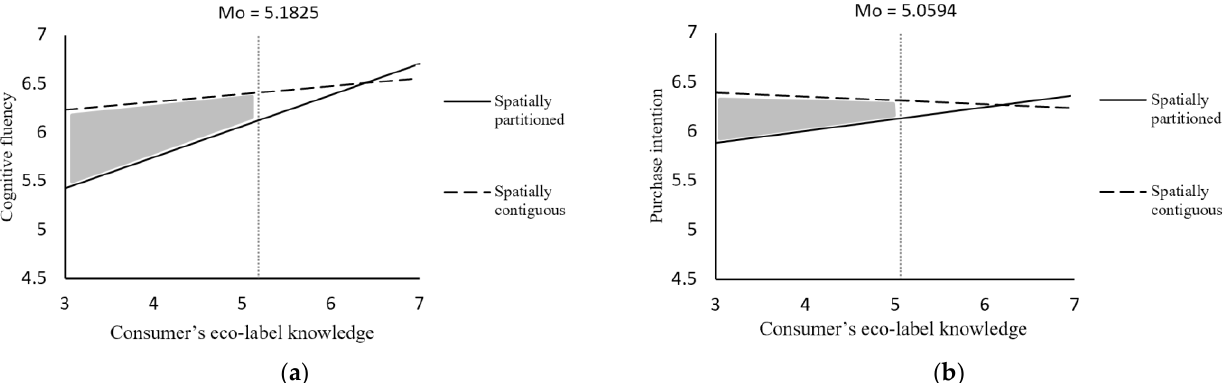
Figure 3. The interactive effect of JPEI spatial distance and consumers’ eco-label knowledge (Study 2). Note: ( a ) shows the interaction effect with cognitive fluency as the dependent variable; ( b ) shows the interaction effect with purchase intention as the dependent variable. The shaded area is the Johnson – Neyman significant area.